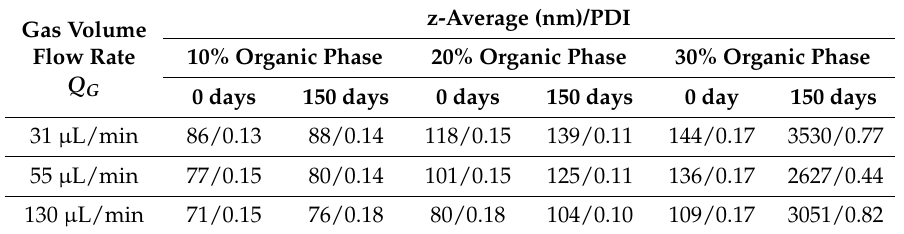
Table 1. Results of long-term stability investigation. For three different volume flow rates of the gas phase and for all concentrations of the organic phase, DLS particle measurements directly after production and 150 days later are compared. Values for average particle size and PDI are given.